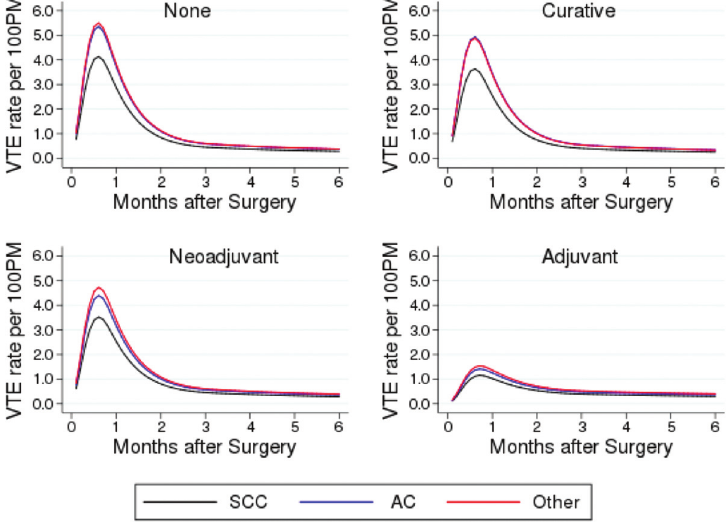
Fig. 1 Adjusted risk of VTE development over time for all stages ( p < 0.002), and histology ( p for adenocarcinoma ¼ 0.012). AC, adenocarcinoma; SCC, squamous cell carcinoma; VTE, venous thromboembolism.